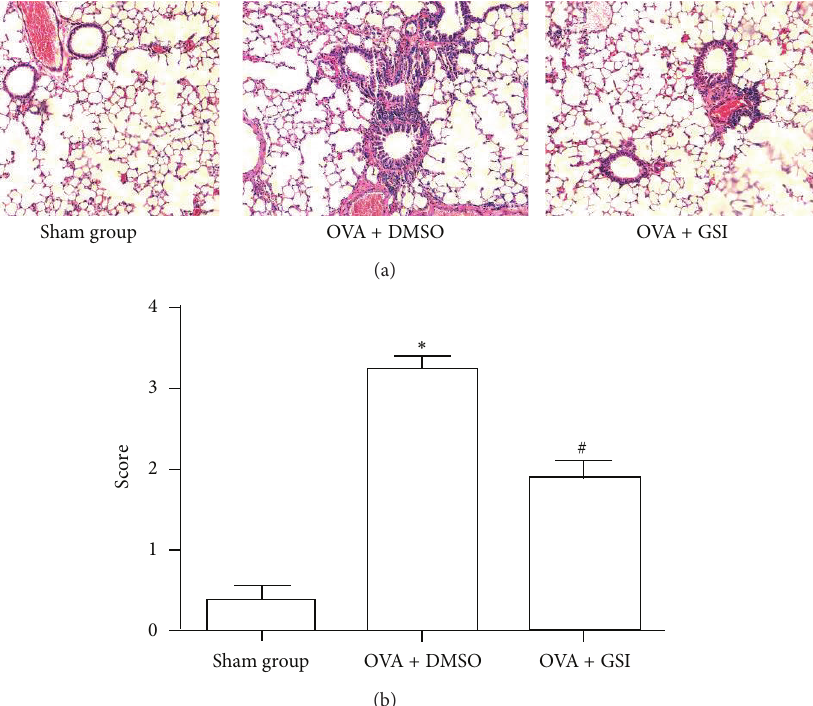
Figure 2: 𝛾 -Secretase inhibitor (GSI) reduced OVA-induced airway inflammation. (a) BALB/C mice were sensitized i.p. with OVA and challenged with OVA in the presence and absence of GSI. Mice were sacrificed within 24 hr after last challenge. Lung tissues were stained with haematoxylin and eosin and subjected to light microscope ( × 200) examination. (b) Semiquantitative pathology scores among sham, OVA, and OVA + GSI groups. Data expressed as Mean ± SEM. 𝑁 = 8 mice per group. ∗ 𝑃 < 0.01 compared with the sham group; # 𝑃 < 0.01 compared with the vehicle group.